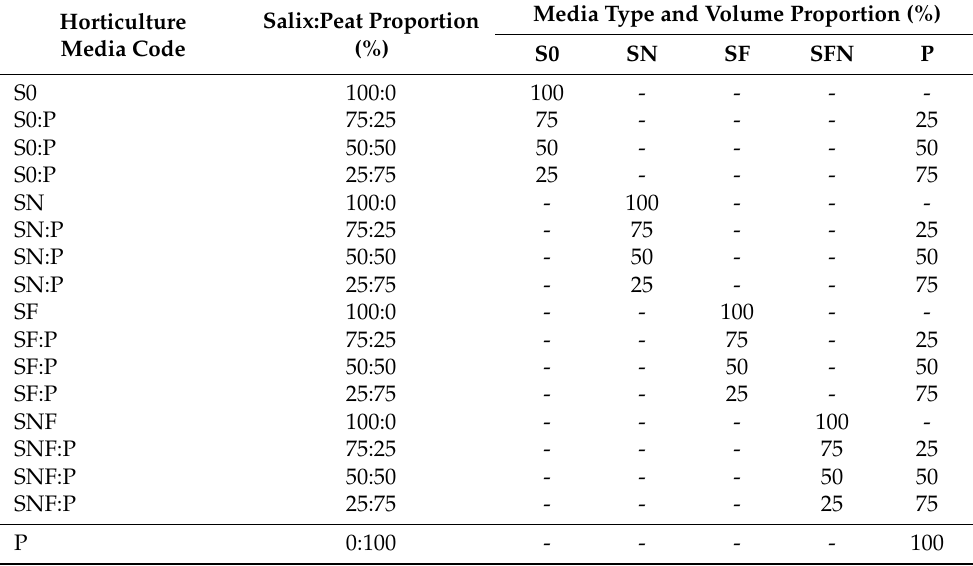
Table 1. Horticulture media mixtures in % of